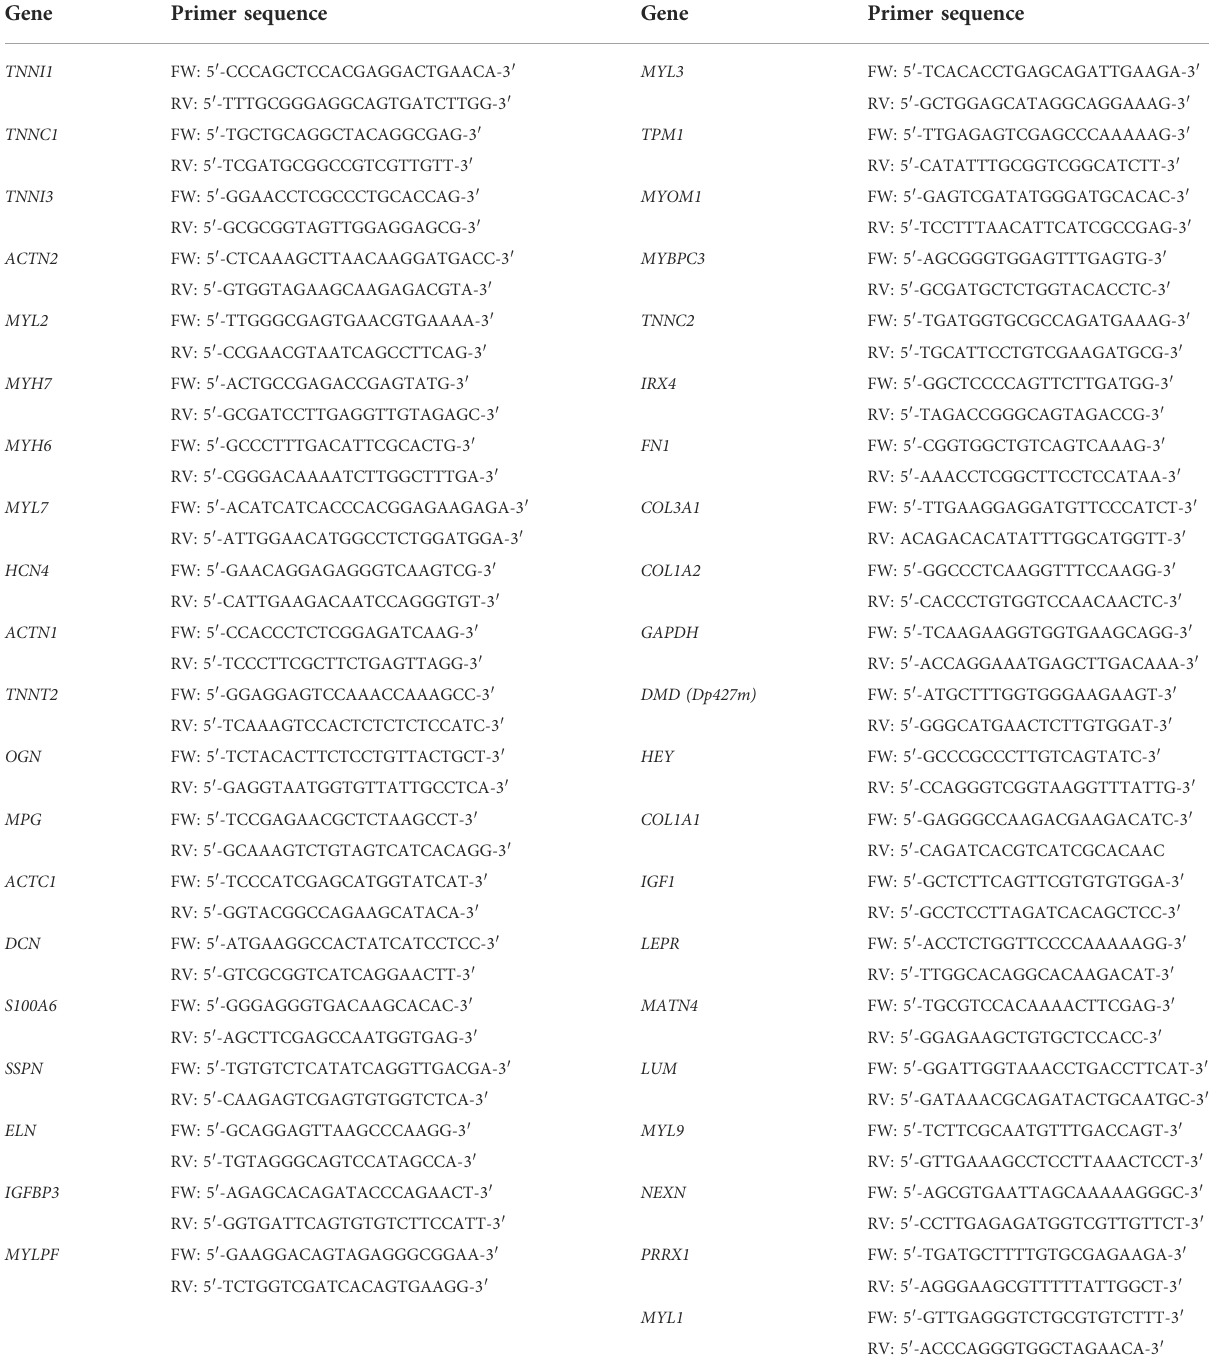
TABLE 1 List of primer used for gene expression